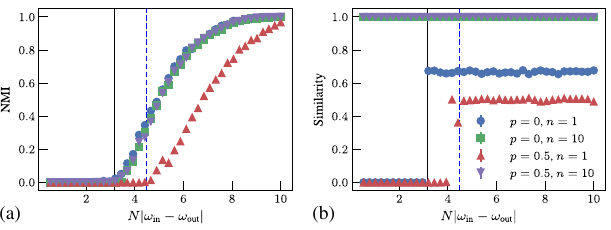
FIG. 8. (a) Normalized mutual information (NMI) between planted and inferred partitions for a PP model with N ¼ 10 4 , B ¼ 2 , h k i ¼ 10 , and measurement errors q ¼ 0 and p given in the legend, together with the number of measurements n . The black solid line marks the threshold of Eq. (55), and the blue dashed line the threshold of Eq. (56) with ð p; q Þ ¼ ð 1 = 2 ; 0 Þ . ˆ A ; A (cid:3) Þ between the (b) The same as in (a), but for the similarity S ð inferred and true